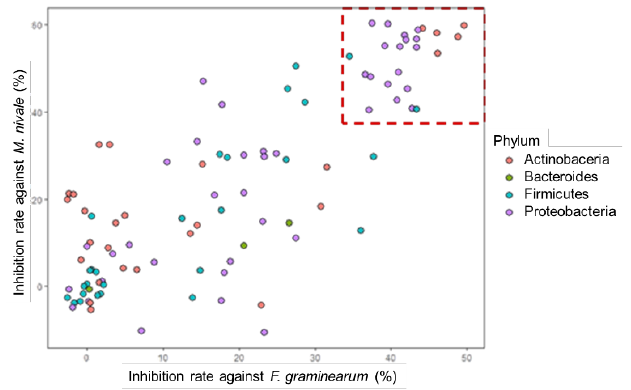
Figure 8. Correlations between antifungal activities against F. graminearum and M. nivale , colored by taxonomical affiliation at the phylum level.